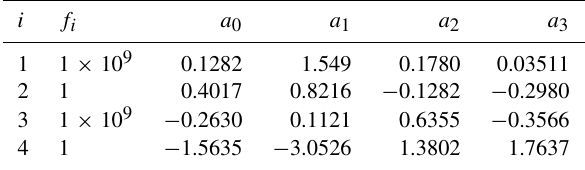
Table 1. Parameters for Eq.